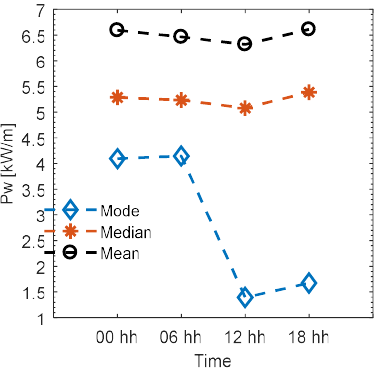
Figure 7. Diurnal variability of wave power in Kilifi based on 6–hourly wave data, showing lower values during day comparing to night.